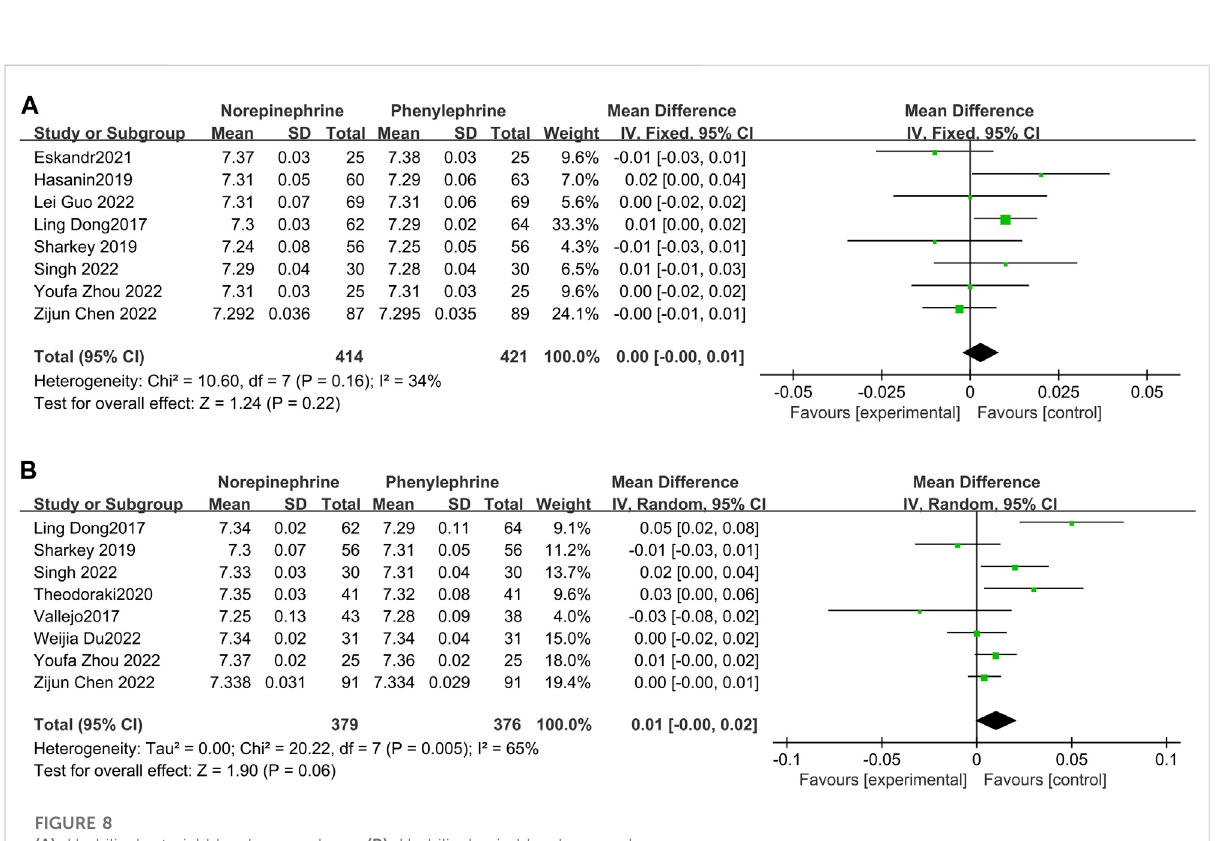
FIGURE 8 (A) : Umbilical arterial blood gas analyses; (B) : Umbilical vein blood gas